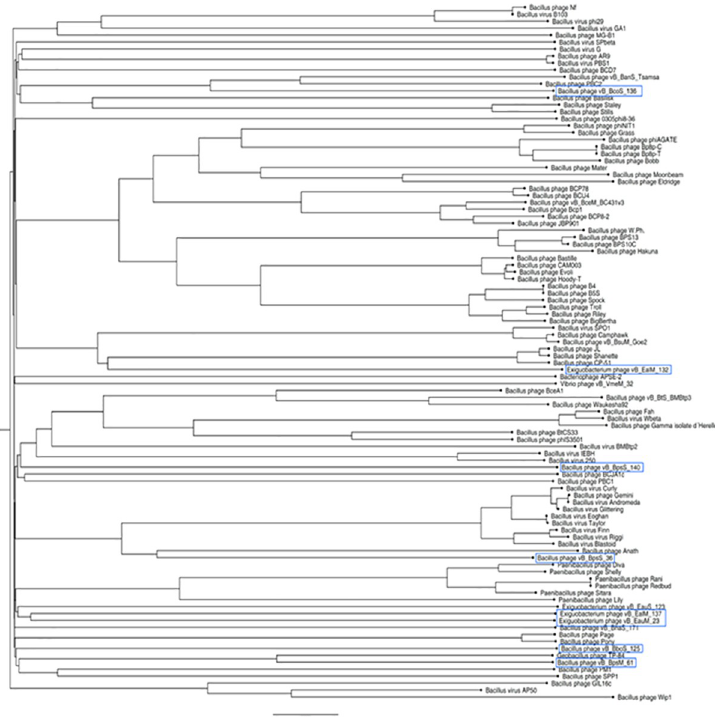
Fig 2. Phylogenomic Genome BLAST Distance Phylogeny (GBDP) tree of isolated phages of this study compared to Bacillus phages. Tree was generated by VICTOR and visualized with Fig Tree. Phages of this study are marked in